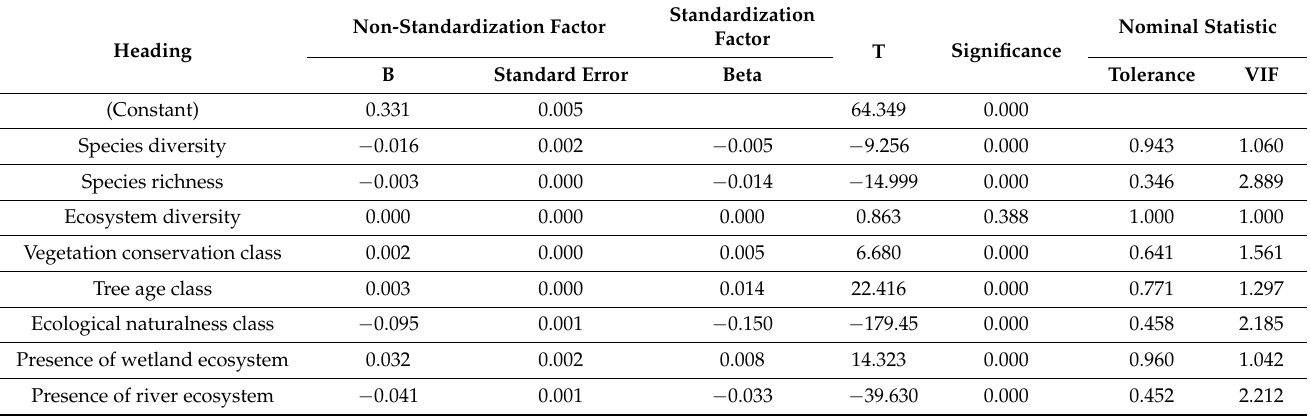
Table 2. Results of multicollinearity analysis of 14